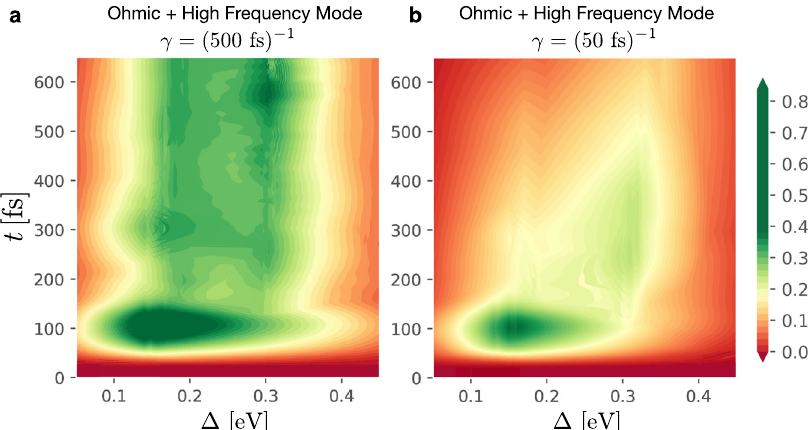
P t Þ , is shown k ð ¼ 5 P t Þ and can be thought as a measure of the probability of k ð ¼ 5